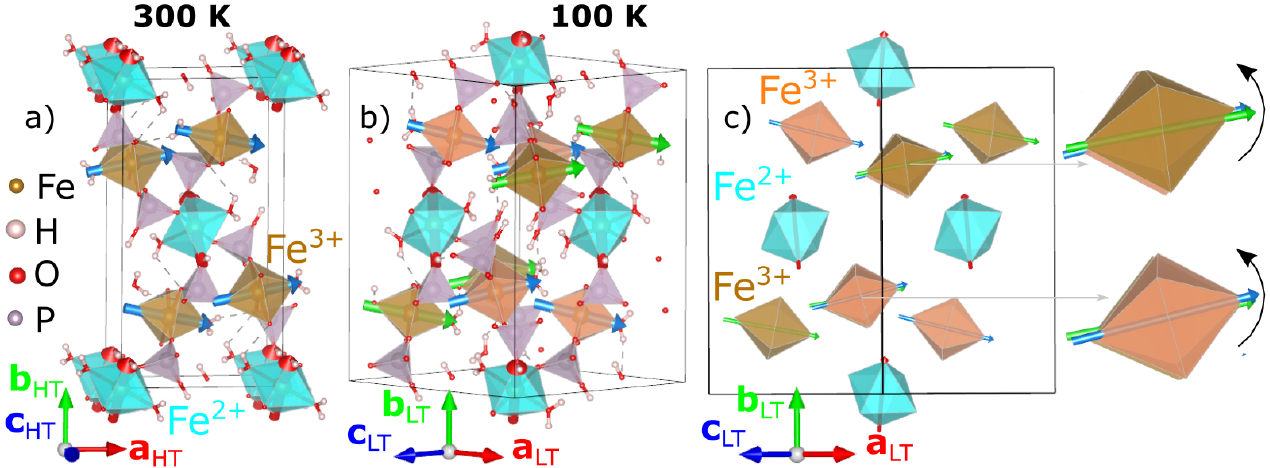
Figure 1. Panels ( a,b ), shows the crystal structures at 300 K and 100 K from laboratory X-ray data; Fe 2+ O 6 and Fe 3+ O 6 octahedra are colored cyan and beige for the 300 K crystal structure, while they are colored cyan, beige and orange for the 100 K crystal structure; colored arrows are plotted inside the octahedra along the largest Fe-O bonds. Panel ( c ) shows a schematic view of the 100 K crystal structure, showing the three inequivalent octahedra and emphasizing the rotation (black arrow) of the two Fe 3+ octahedra with respect to the 300 K crystal structure. The relation between the low-temperature ( a LT , b LT , c LT ) and room-temperature ( a HT , b HT , c HT ) lattice vectors is given by a LT = a HT + c HT , b LT = b HT , c LT = − a HT + c HT .